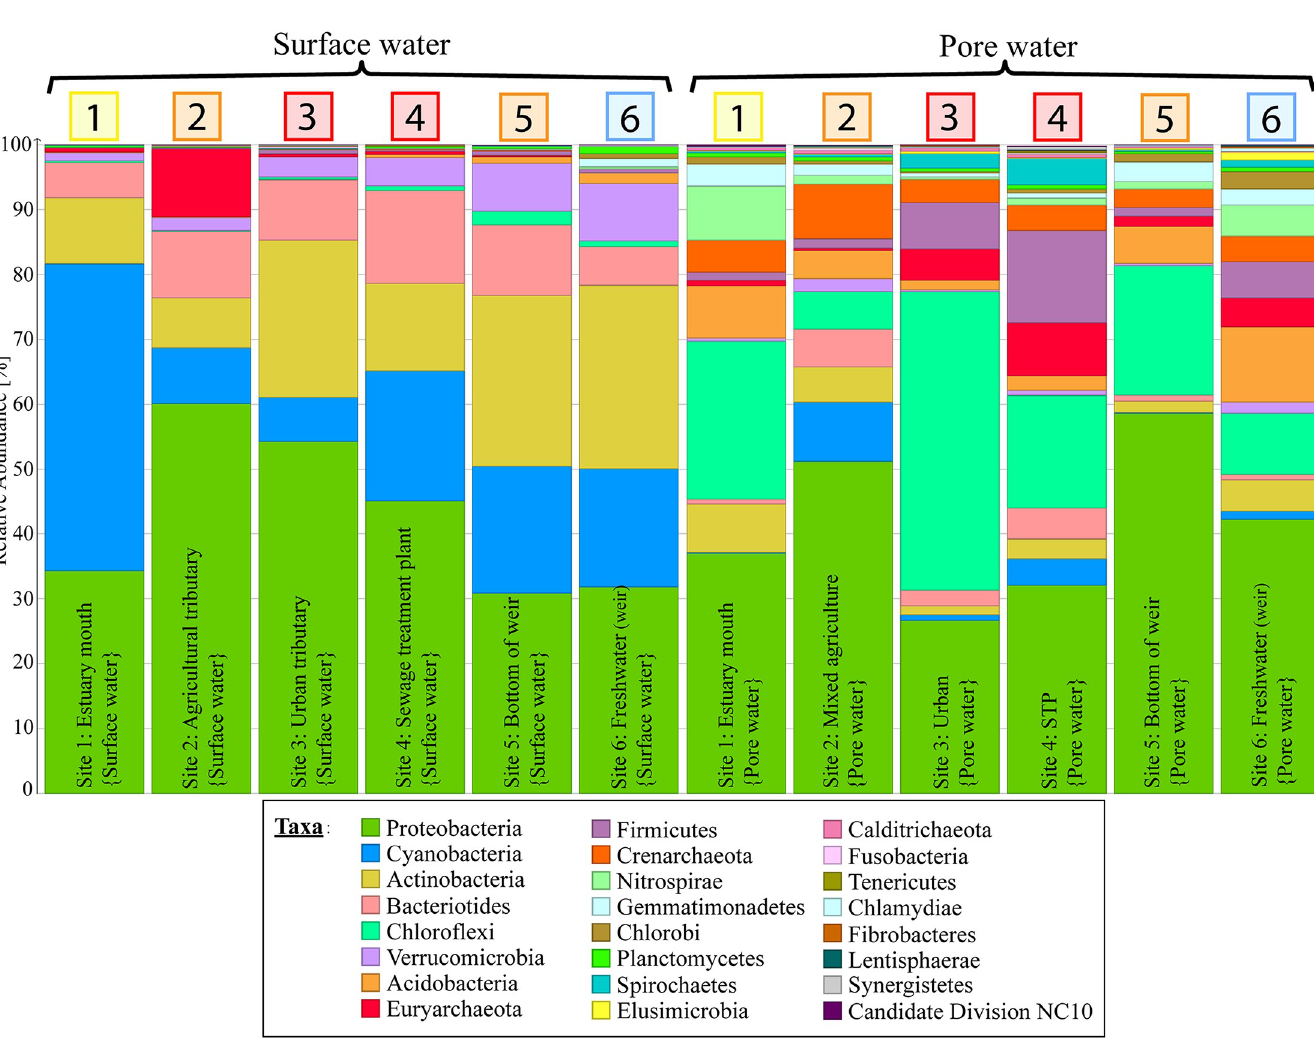
Fig 5. Community bar plot of prevalent prokaryotic phyla in the Burnett River estuary. Relative abundances are depicted for each phylum per sampling site. Phyla with an abundance of < 0.1% in all individual samples were discarded.